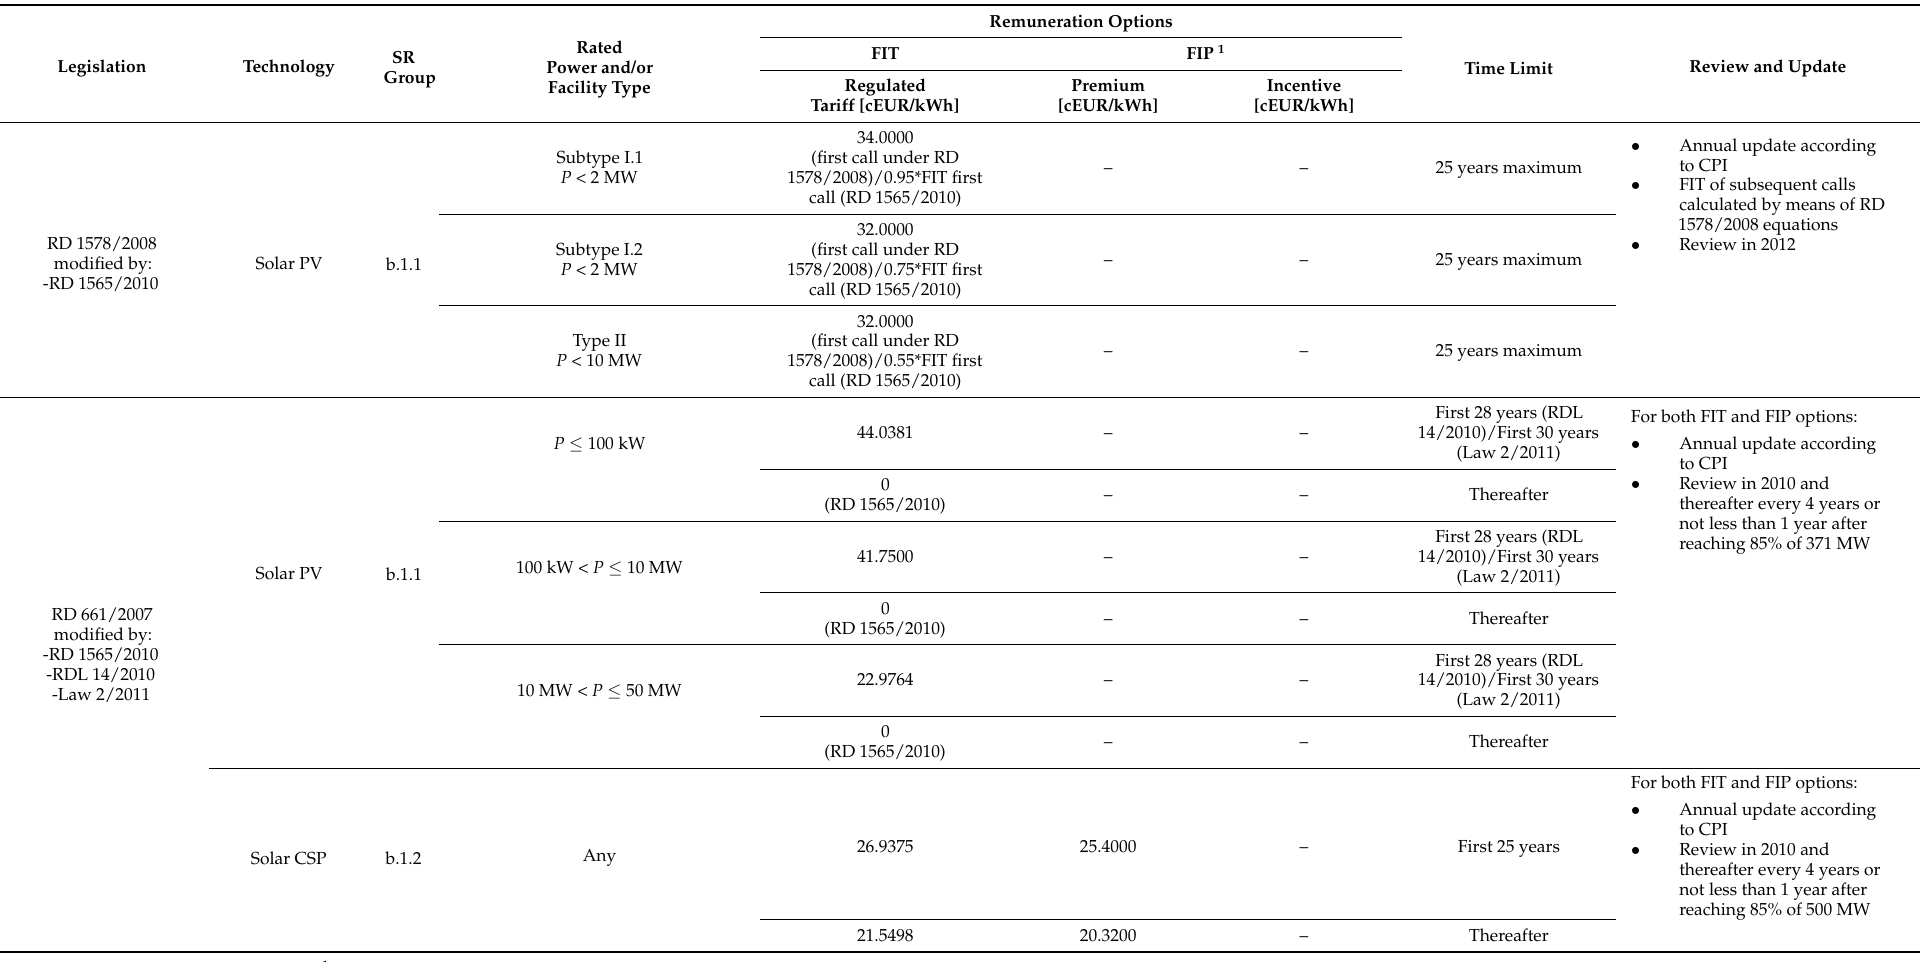
Table 6. Major characteristics of the different economic regimes in force for solar power systems in Spain in the period 2008–2013. Source: self-elaboration based on